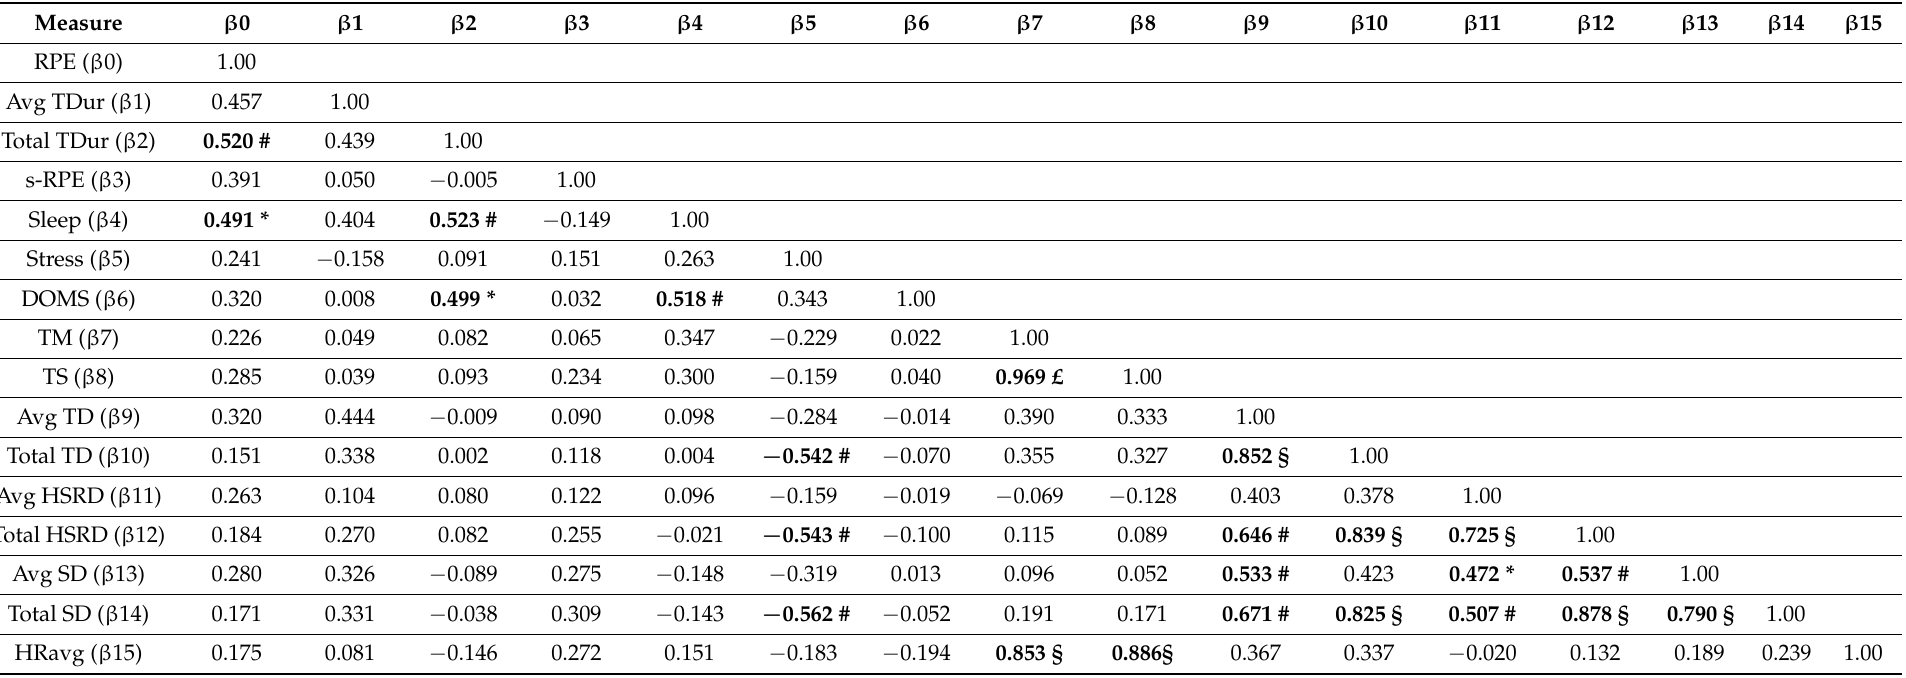
Table 3. Correlation analysis between the measures in study on the